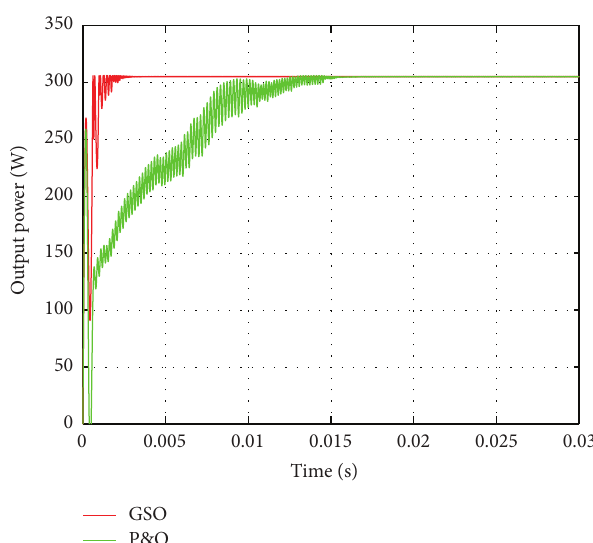
Figure 13: Outputpower ofthePVmodulefortheGSO method and P&O method under 1000 W / m 2 , 25 ∘ C.